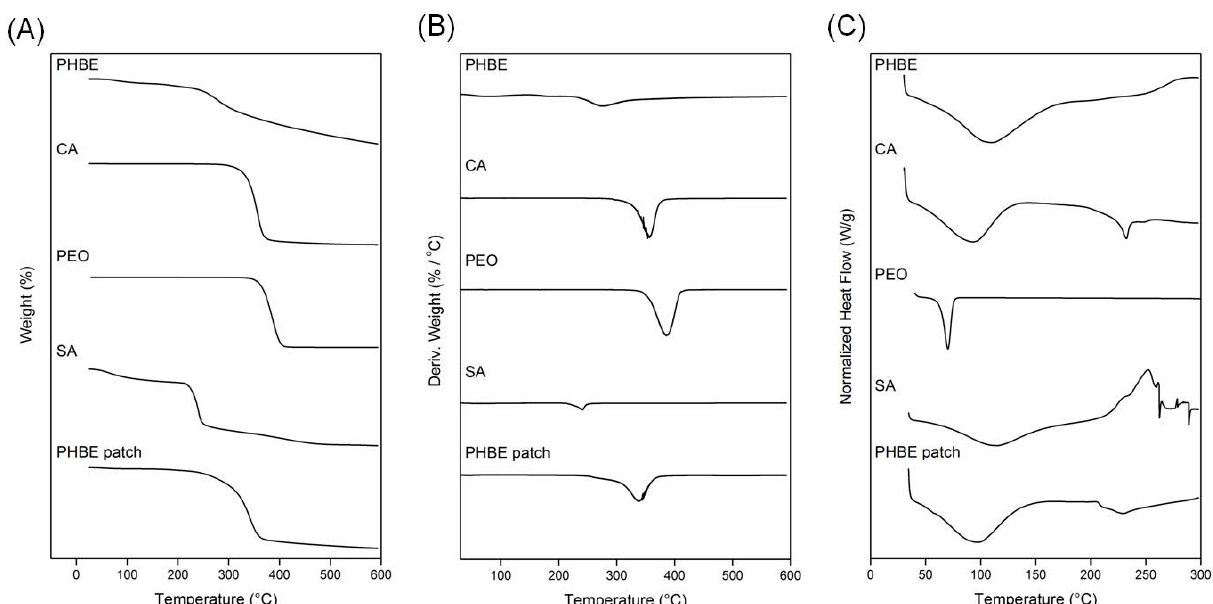
Figure 2. ( A ) TGA, ( B ) DTG and ( C ) DSC thermograms of the raw materials and the electrospun PHBE micro/nanofibrous patch.